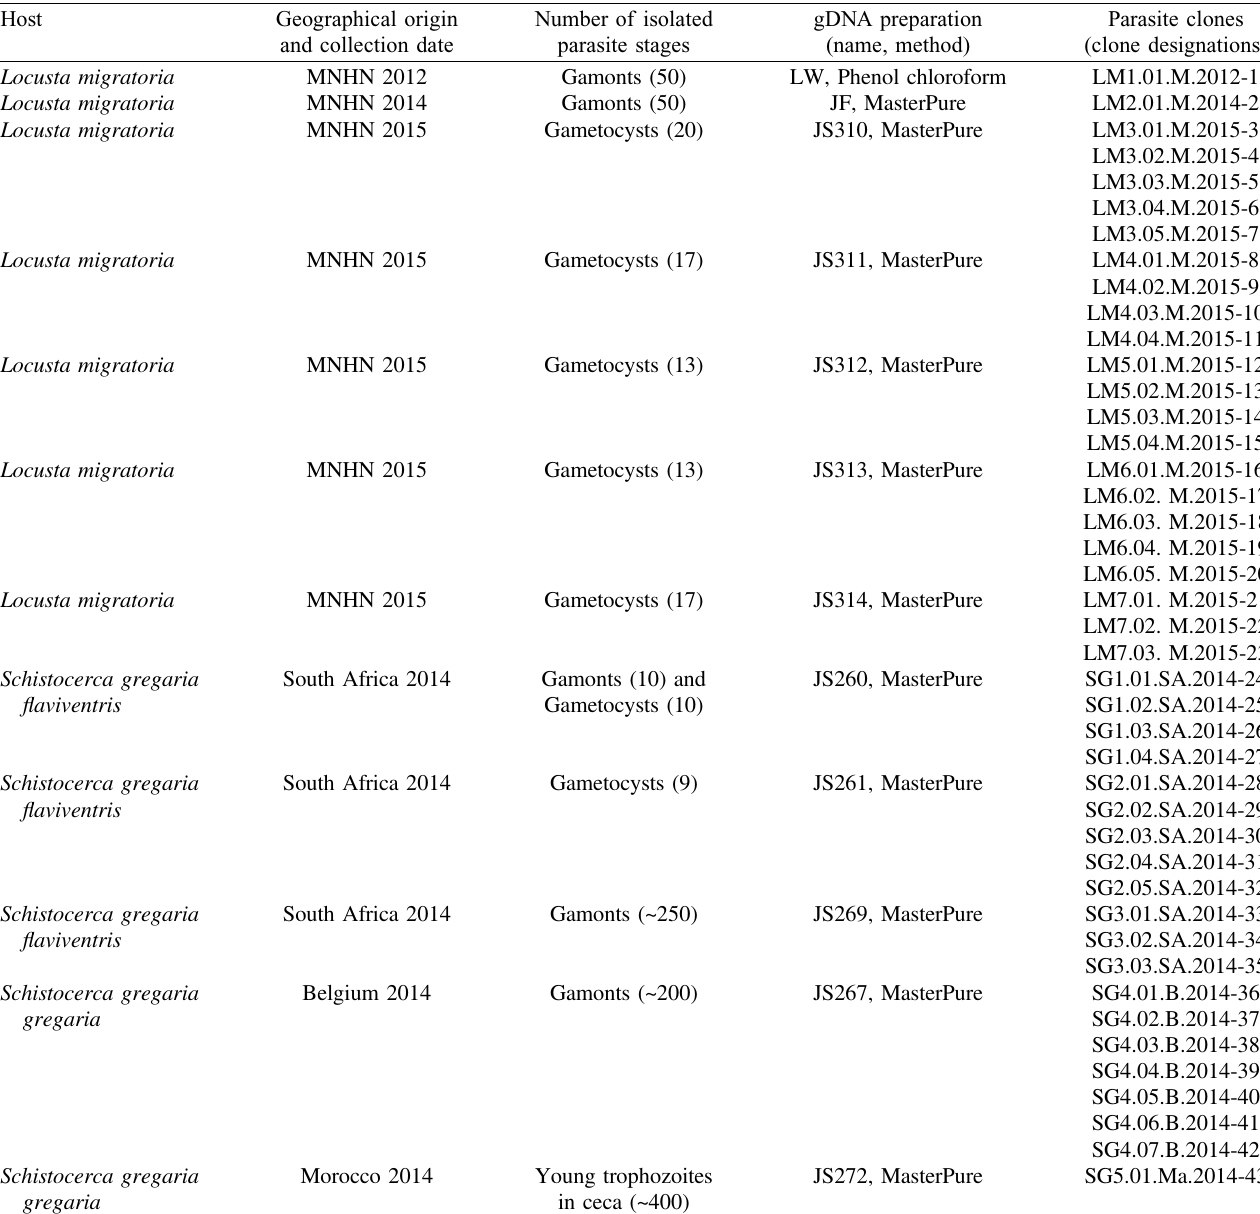
Table 3. Gregarine specimens isolated for molecular